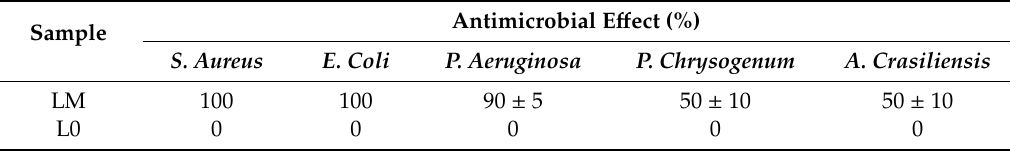
Table 7. Antimicrobial e ffi ciency of non-pigmented coating films.